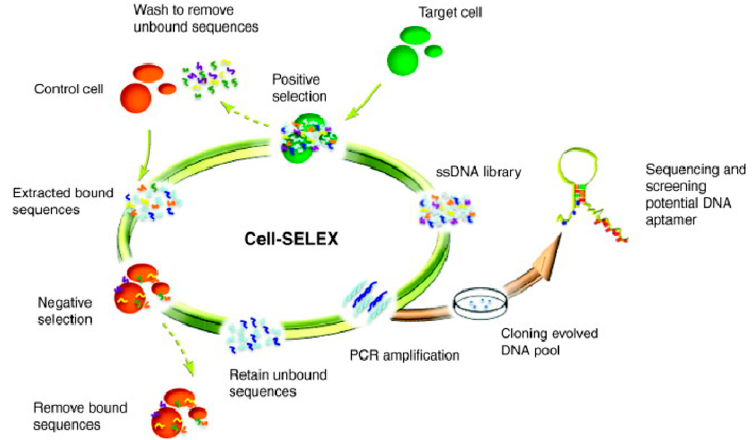
Figure 1. Schematics of cell-based aptamer selection.